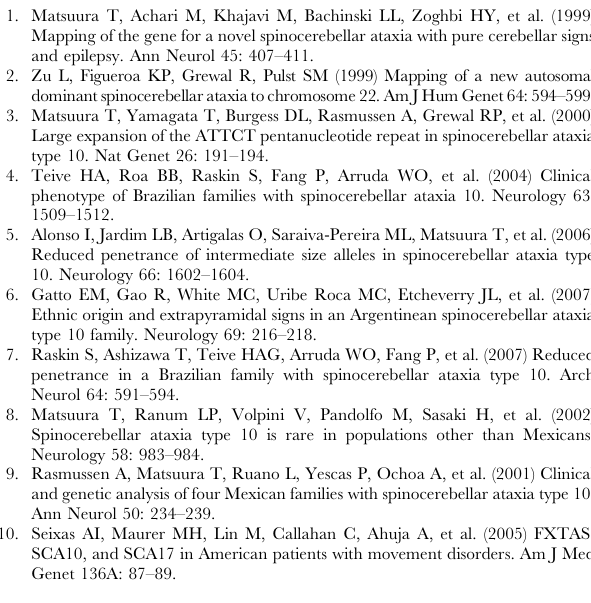
Table S2 Haplotype Frequencies in Controls by Lineage